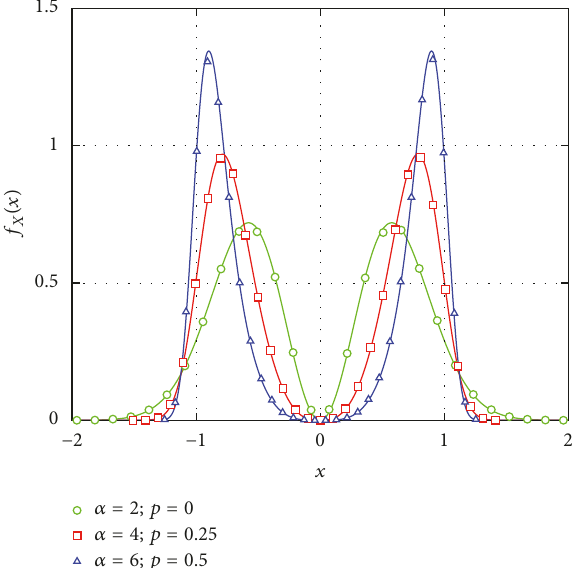
Figure 1: Empirical and theoretical 𝛼 - 𝜇 envelope distribution with 𝜇 = 3 and irrelevant 𝑝 .